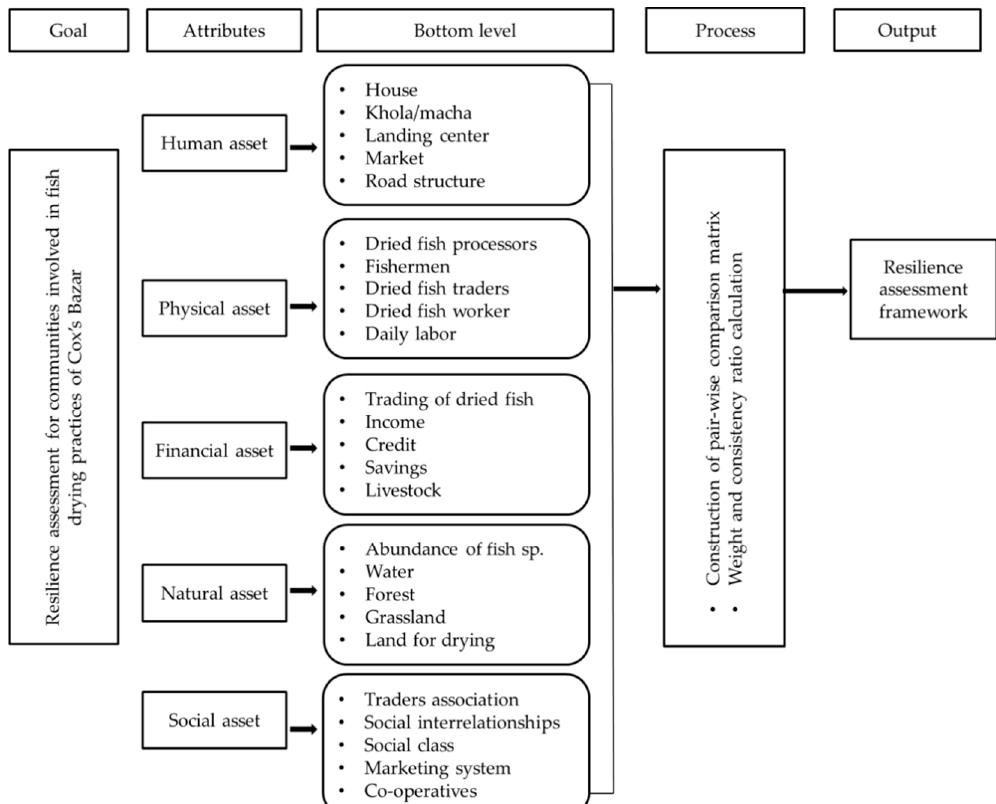
Figure 2. The adapted analytical hierarchy process (AHP) for resilience assessment of communities involved in fish drying practices in the Cox’s Bazar region of